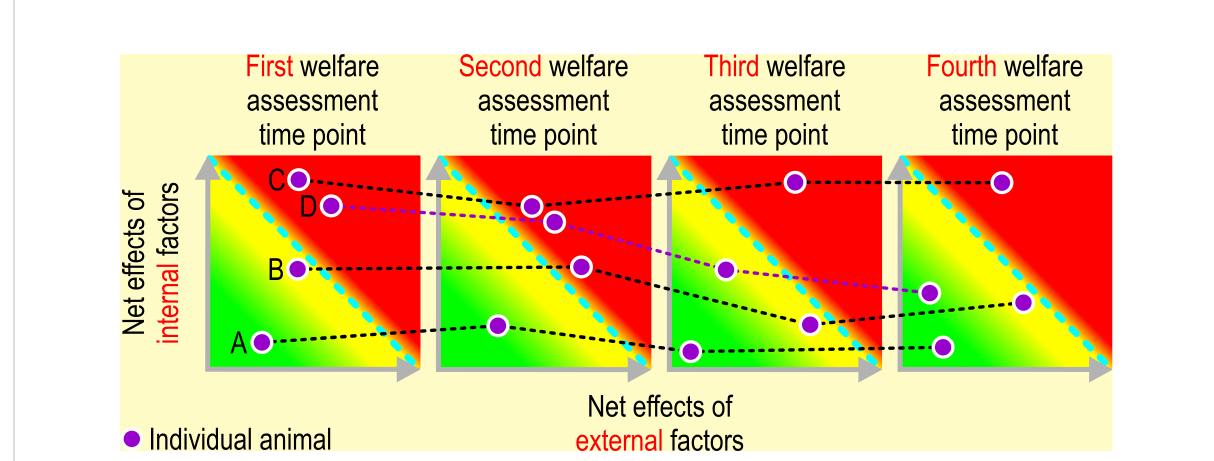
FIGURE 6 Repeated assessment of animal welfare. Drawing conclusions about animal welfare must be based on assessing an animal ’ s emotional and physiological state repeatedly over a longer period of time. Individual A: the welfare of this animal is not at stake at any of the four welfare assessment time points, i.e., the impact of net effects of adverse internal and external factors never exceeds its limit of adaptability. The net impact of appetitive and adverse internal and external factors exceeds the limit of adaptability of animal B at the second time point, whereas its welfare is compromised on time points 1, 3, and 4. The welfare of animal C is seriously impaired on all assessment time points, i.e., the impact of adverse internal and external factors always exceeds its limits of adaptability. Animal D, an overweight, brachycephalic dog underwent surgery to alleviate its dyspnea (reducing impact of an adverse internal factor) between the second and third welfare assessment time point. Also, the feeding regime was improved to induce signi fi cant weight loss (reducing the impact of an adverse external factor, namely malnutrition). The condition of this dog is slowly